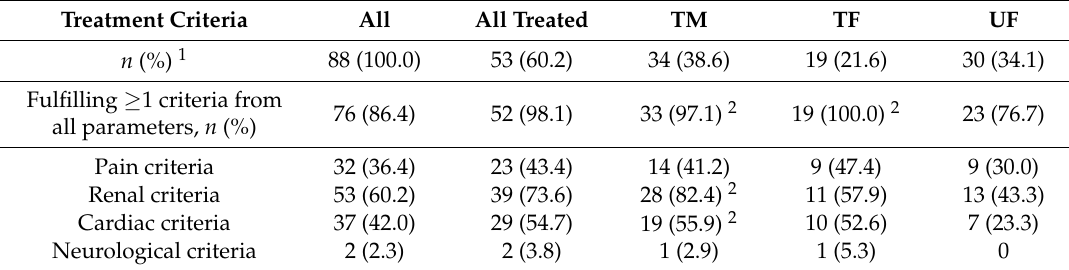
Table 2. Description of the distribution of Spanish patients included in the FOS registry in August 2014 according to the criteria for treatment initiation stated in the Spanish national consensus of 2005 [24], updated in 2011 [25], by gender and treatment